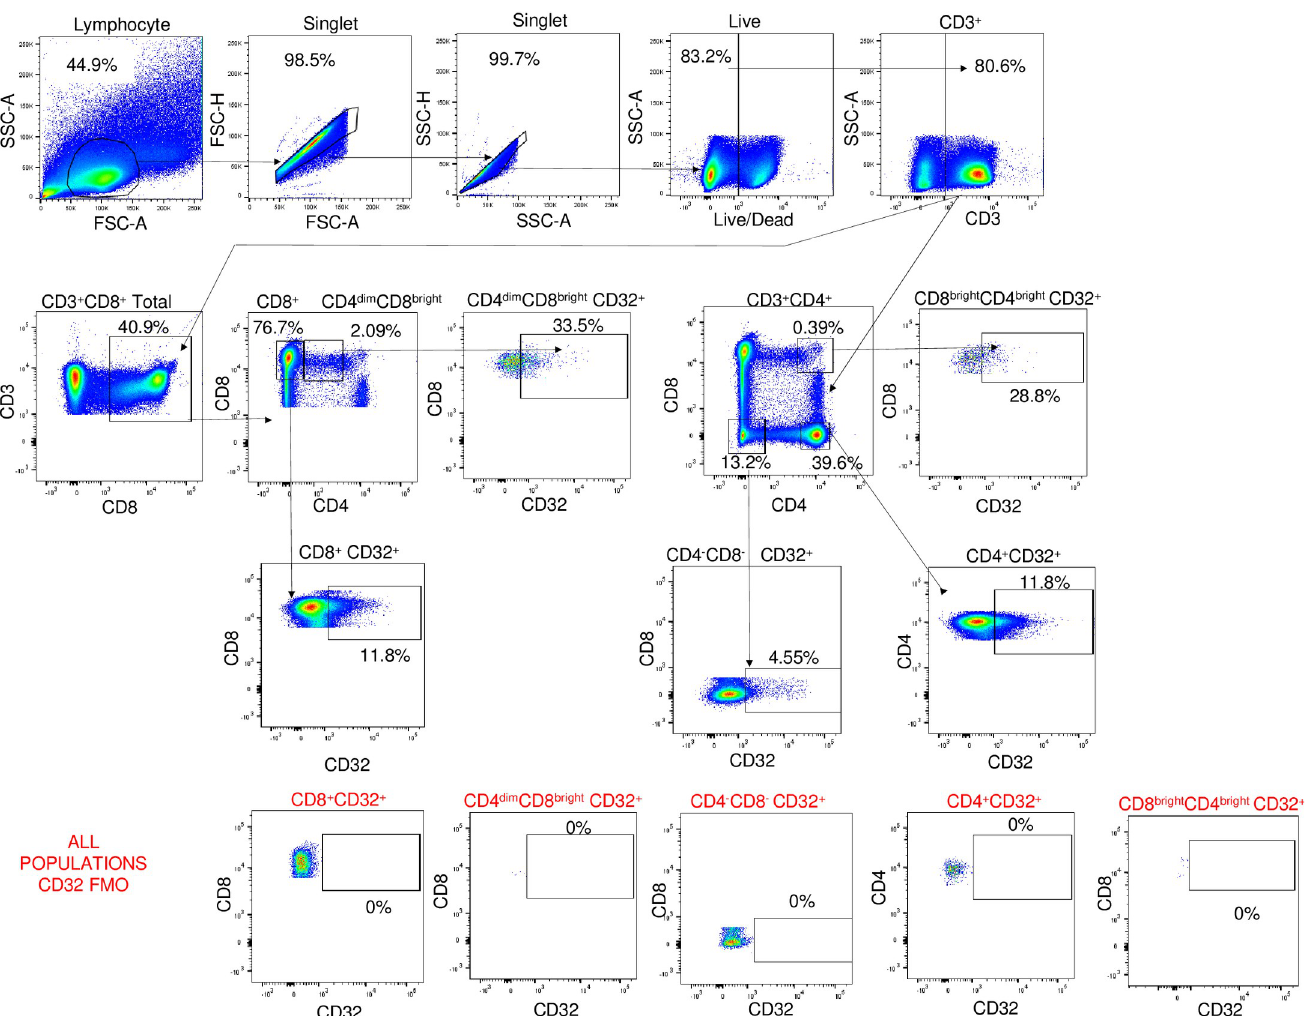
Fig 1. Gating strategy for CD32 expression on peripheral CD4 + and CD4 dim CD8 bright T cell populations. Lymphocytes were gated from whole human PBMCs using forward and side scatter area, then two singlet gates were utilized to remove doublet populations. This was followed by an Aqua Live/Dead stain and total CD3 + cell gate. From this, two different gates were determined: total CD3 + CD8 + cells and CD3 + CD4 single positive cells. From the CD3 + CD8 + cells, CD8 single positive T cell and CD4 dim CD8 bright T cell populations were obtained. CD4 single positive T cells, CD4brightCD8bright, and CD8 - CD4 - were gated from total CD3 + cells. The results of these gates are five T cell populations: CD8 + , CD4 dim CD8 bright , CD4 + , CD4 bright CD8 bright , and CD8 - CD4 - . CD32 expression was determined through usage of a CD32 FMO, which was used as a negative control for CD32 staining and allowed for accurate gating on the positive populations